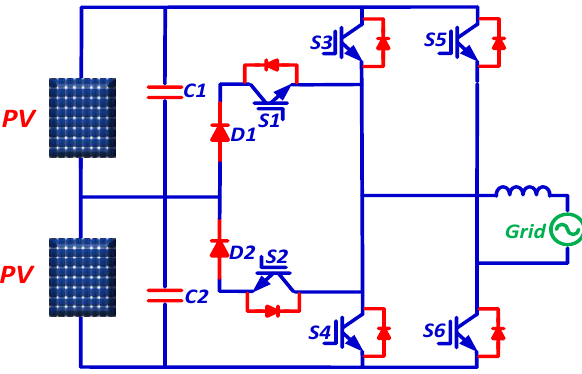
Figure 5. Full-bridge single-leg switch clamped inverter [51].